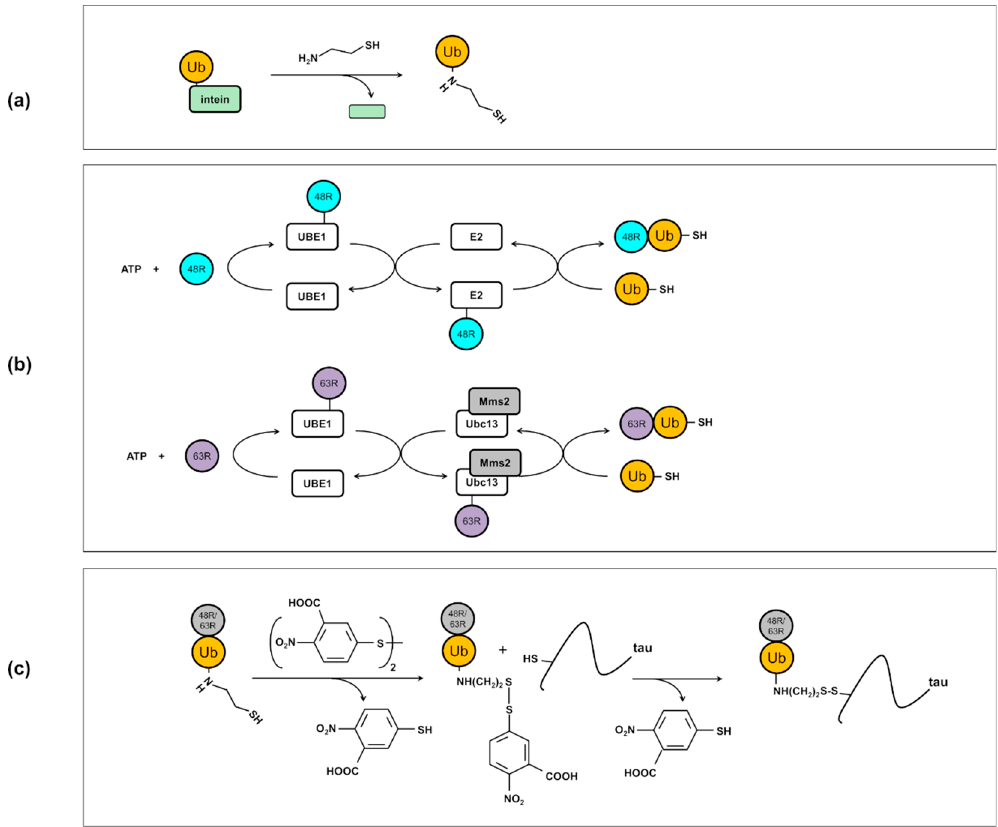
Figure 2. ( a ) Scheme of cysteamine-mediated cleavage of Ub-SH from a ubiquitin-intein fusion protein. We produced a chimeric protein where ubiquitin was cloned to the N-terminal of the GyrA intein. A ubiquitin with a C-terminal aminoethanethiol linker (Ub-SH) was obtained through a trans-thioesterification reaction between intein and cysteamine, followed by a S-to-N acyl shift. ( b ) Scheme of production of Ub 2 (48)-SH and Ub 2 (63)-SH di-ubiquitin molecules by enzymatic reaction. For the controlled assembly of K48-linked chains, the enzymes E1 and E2-25K were used. For the K63-linked chains, we used E1 and the complex Mms2/Ubc13. ( c ) Reaction of Ub 2 (48/63)-SH with 5,5 ′ -Dithiobis(2-nitrobenzoic acid) gave an activated asymmetric disulfide. This was then allowed to react with the unique cysteine placed in position 353 in tau4RD to obtain the disulfide-linked Ub 2 (48)tau4RD(353) and Ub 2 (63)tau4RD(353) conjugates.